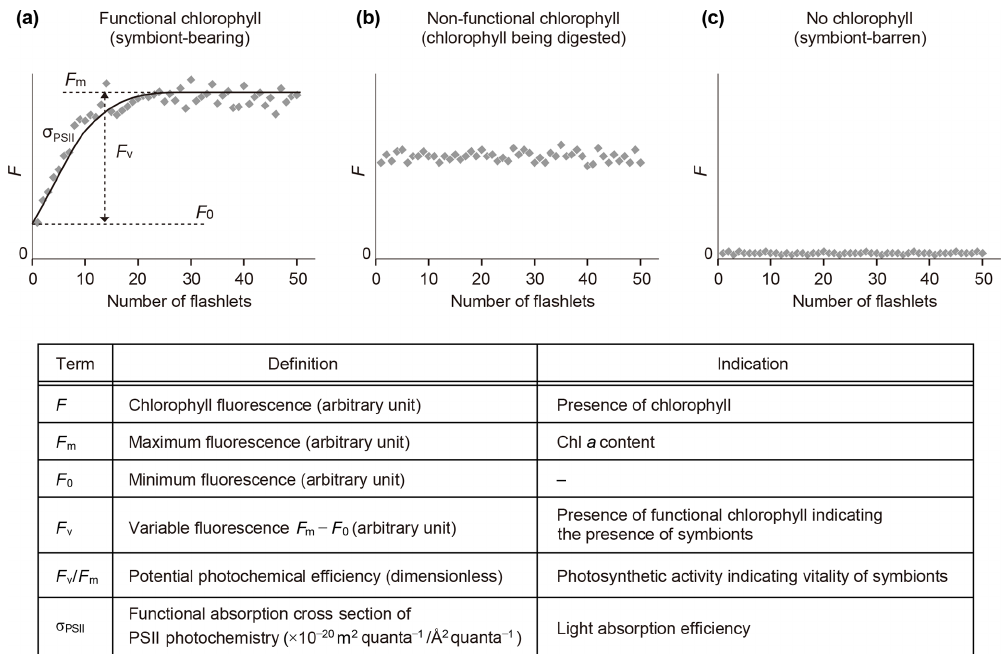
Figure 3. Schematic diagram of fluorescence induction curves by fast repetition rate fluorometry and their interpretation. (a) Profile of a symbiotic individual. (b) Profile of a non-functional chlorophyll-bearing individual. (c) Profile of a non-symbiotic individual. Photosystem II parameters used in this study are also listed. All parameters are obtained in dark-adapted